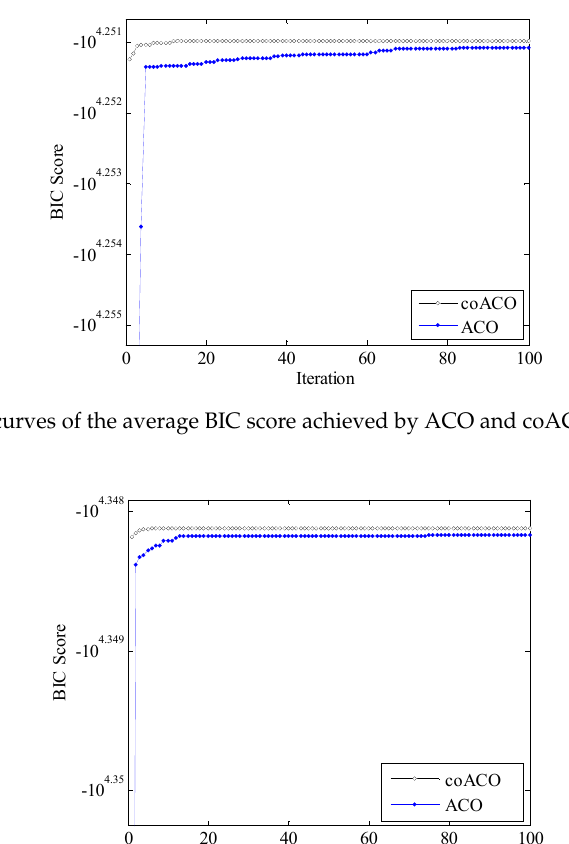
Figure 9. Evolution curves of the average BIC score achieved by ACO and coACO on the ALARM dataset with n = 1000 Figure 10. Evolution curves of the average BIC score achieved by ACO and coACO on the ALARM dataset with n = 5000.